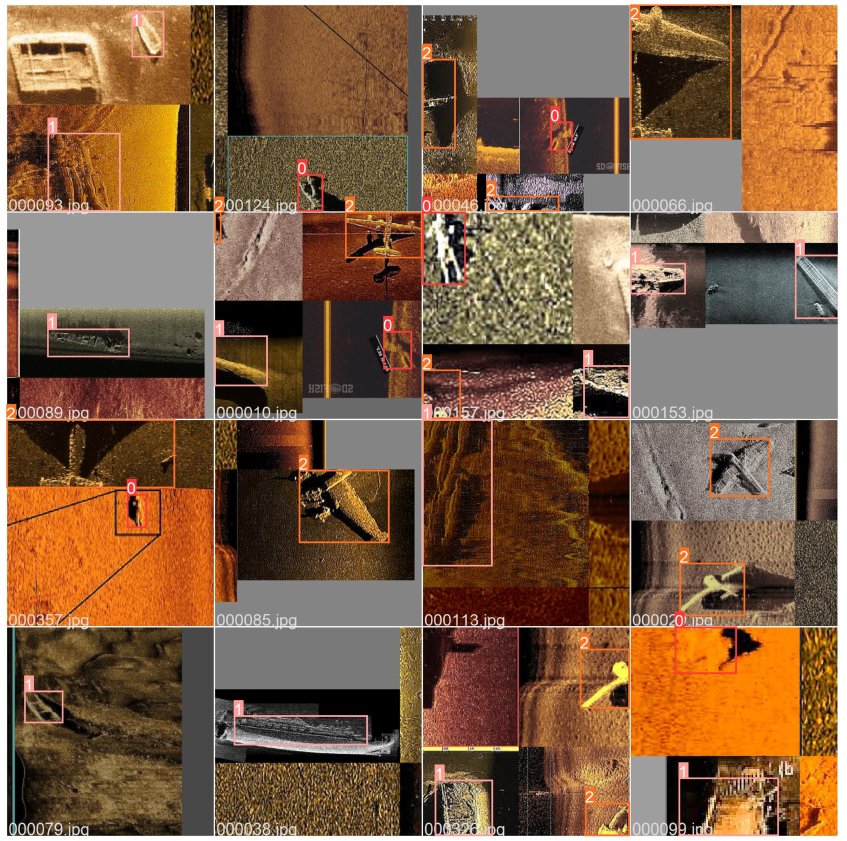
Figure 10. Examples of mosaic image enhancement.